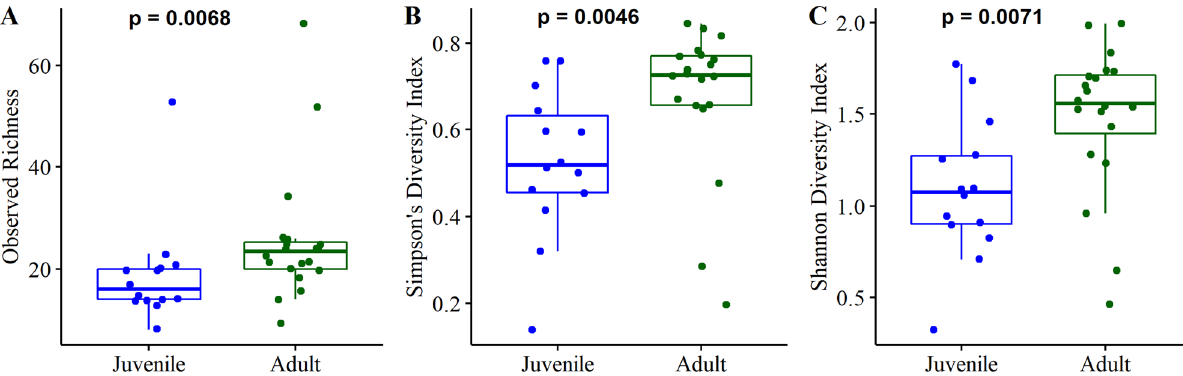
Figure 2. Alpha diversity was significantly lower in juveniles compared to adults when measured as observed richness ( A ), Simpson’s Diversity Index ( B ), and Shannon Diversity Index ( C ). Figure created in R using tidyverse (v. 1.3.1) 96 , cowplot (v. 1.1.1) 97 , and ggpubr (v. 0.4.0) 98